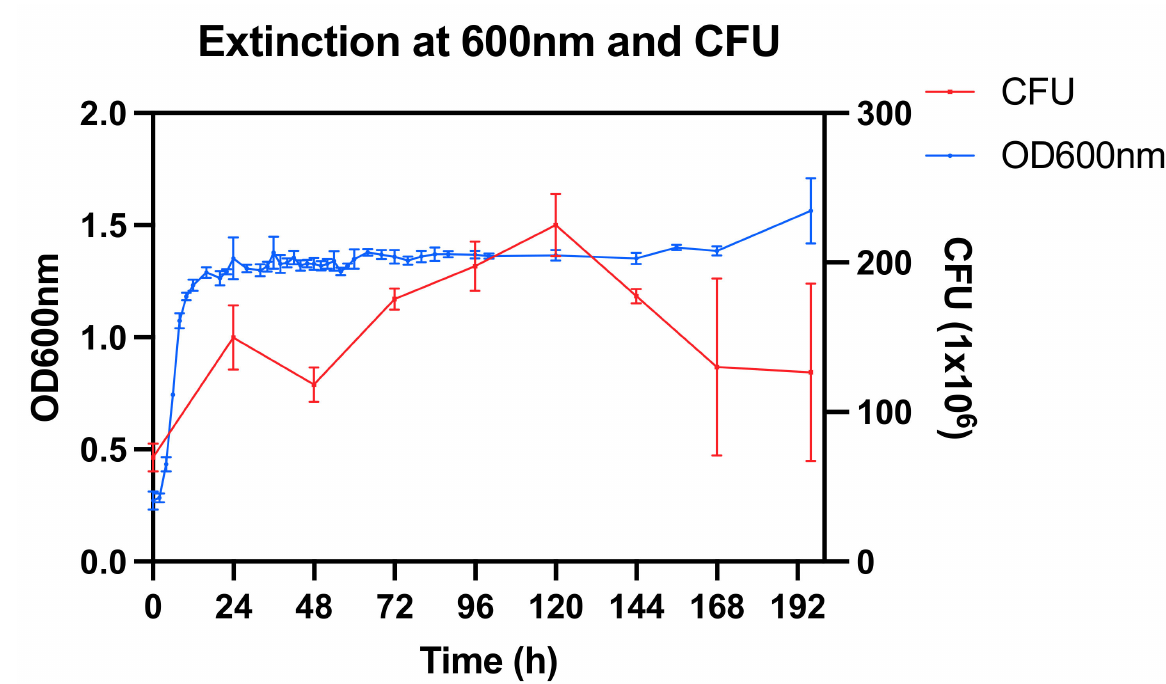
Figure 1. Optical density (OD) at 600 nm and colony forming units (CFU) at 10 6 dilution. Resistance testing revealed a higher antimicrobial effect of the postbiotic supernatant after 48 compared to 196 h (Figure 2). The postbiotic supernatant had no effect against anaerobic bacteria. Supernatant of both time points was reactive against S. epidermidis showing about half the reactivity at 196 compared to 48 h. Buffering reduced the effect of the 48 h supernatant against L. monocytogenes , P. aeruginosae , and E. faecium . Only the effect against C. albicans was negatively affected by cooking and proteinase K